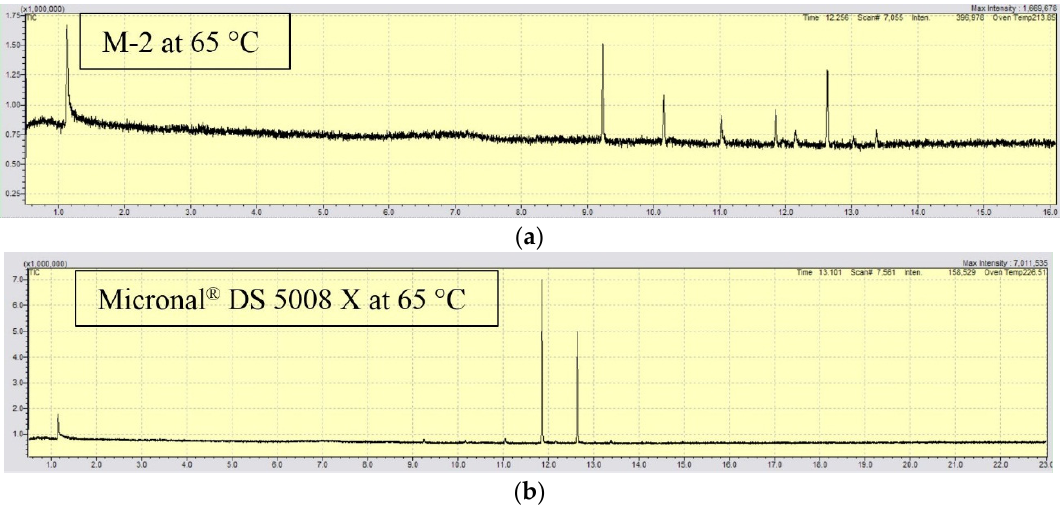
Figure 6. Revealed peaks for the GC/MS analysis for: ( a ) M ‐ 2 and; ( b ) Micronal ® DS 5008 X samples at 65 °C.